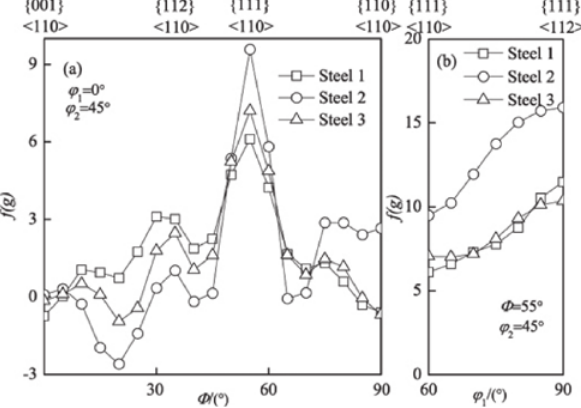
Fig. 9: Orientation distribution intensities of annealed cold-rolled fiber